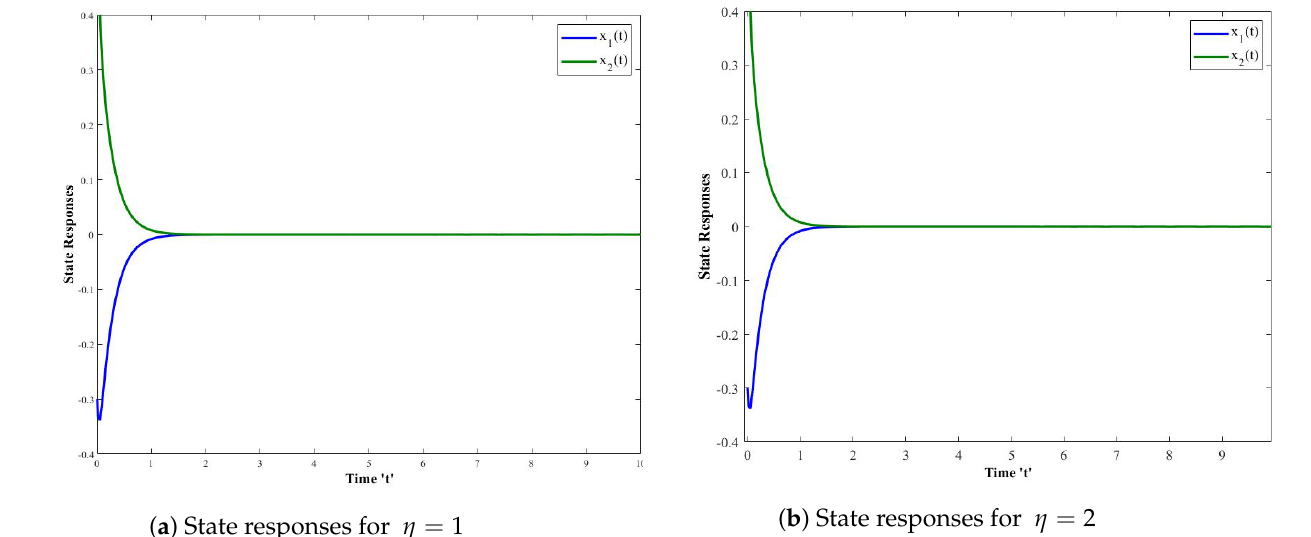
Figure 1. Simulation results for nonlinear TS fuzzy system with absence of uncertain parameters.